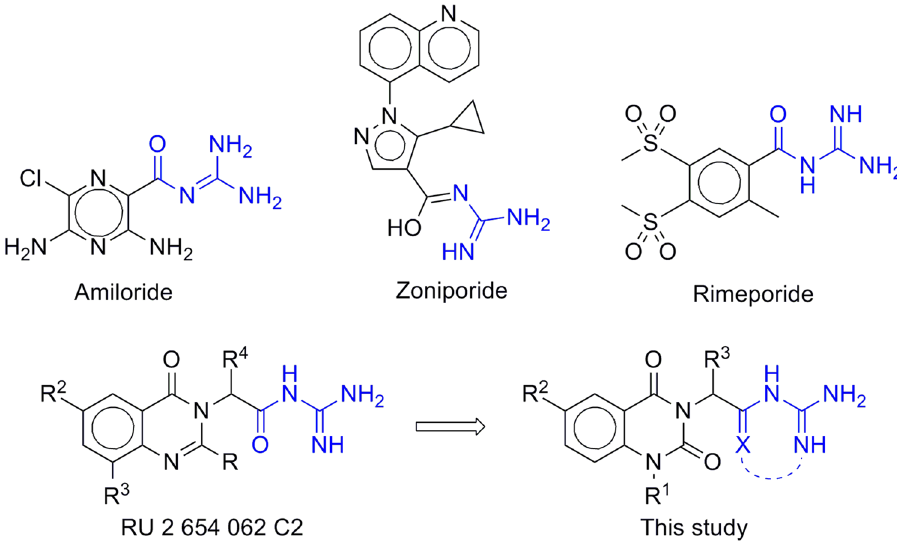
Figure 1. Reference NHE-1 inhibitors and design of the target